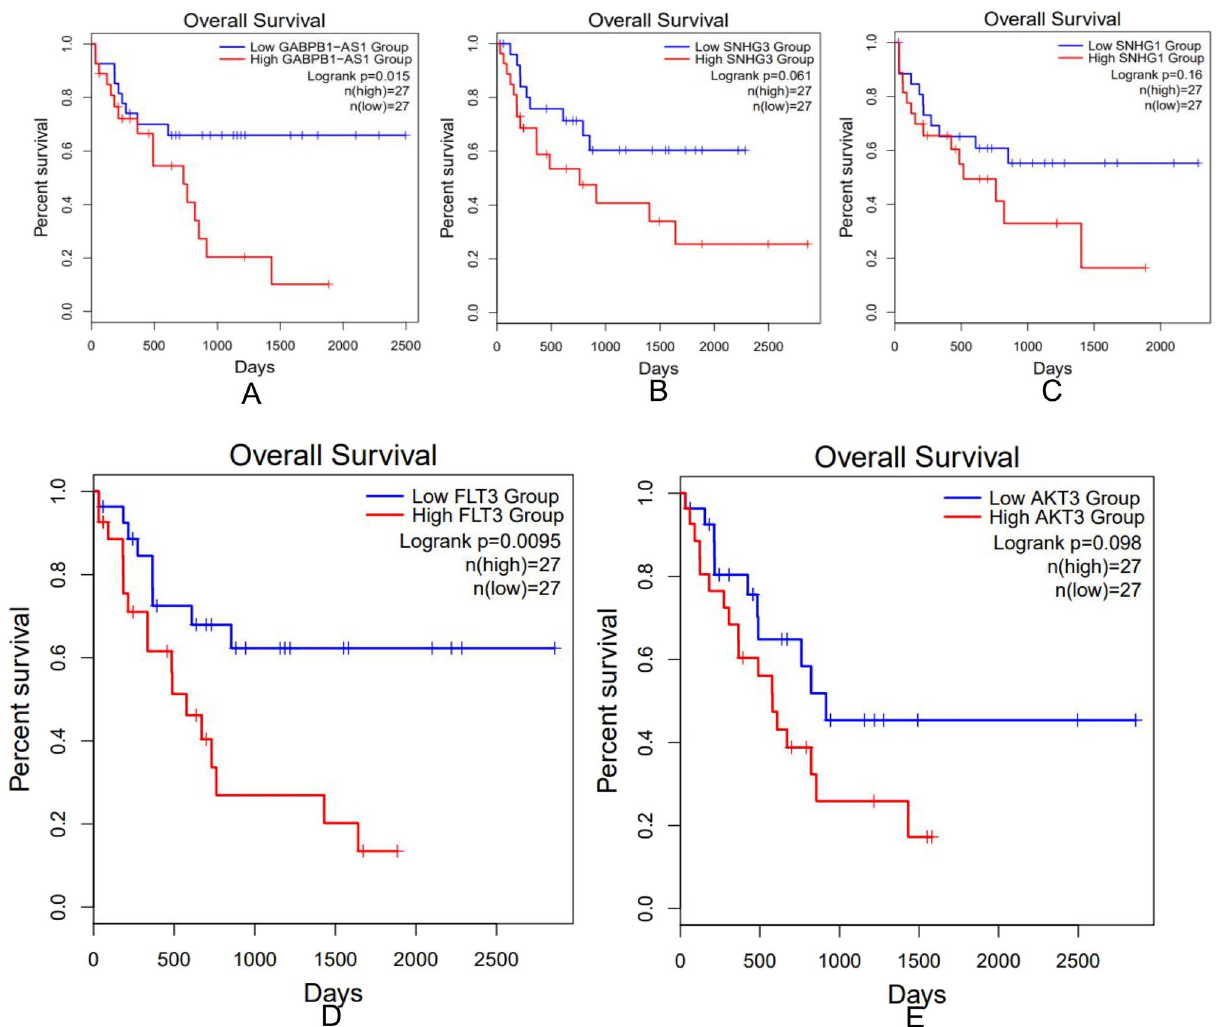
Figure 7. Kaplan–Meier curves of three lncRNAs (GABPB1-AS1 ( A ), SNHG3 ( B ), SNHG1 ( C )) and two mRNA (FLT3 ( D ), AKT3 ( E )) in AML with logrank p < 0.05.